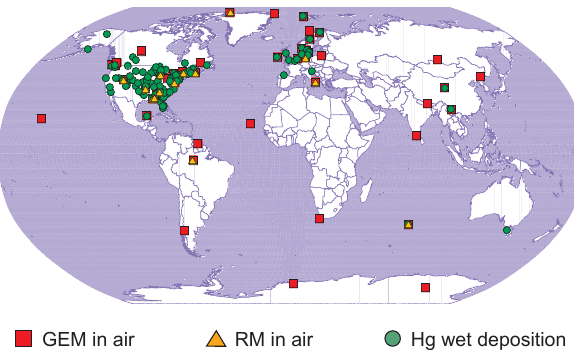
Figure 1. Location of measurement sites used in the study